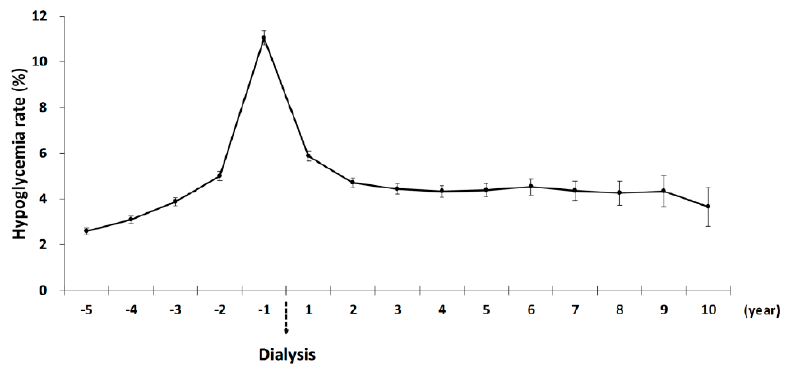
Figure 2. Temporal trends of severe hypoglycemic rates in diabetic kidney patients before and after